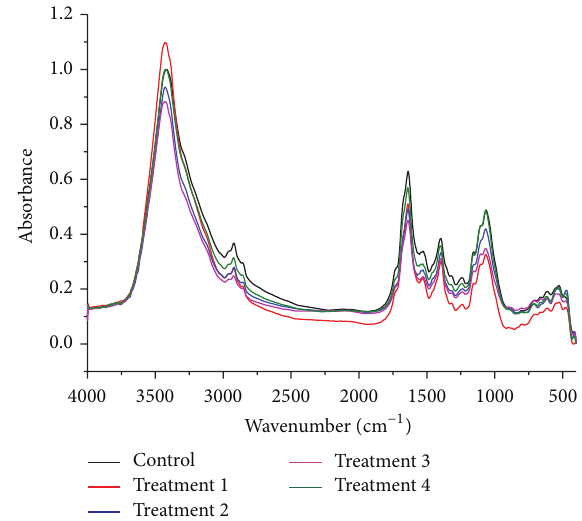
Figure 1: Spectra of control and treated wheat leaves in the wave- number of 4000–400 cm −1